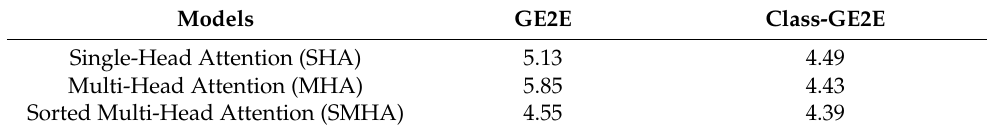
Table 1. Equal error rate (%) of speaker verification systems.